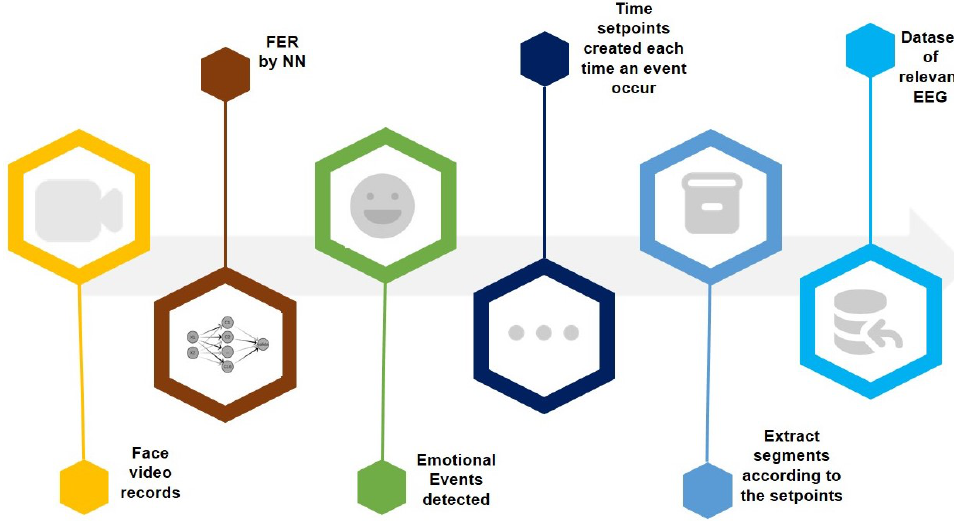
Figure 1. Facial emotion recognition process to create time set